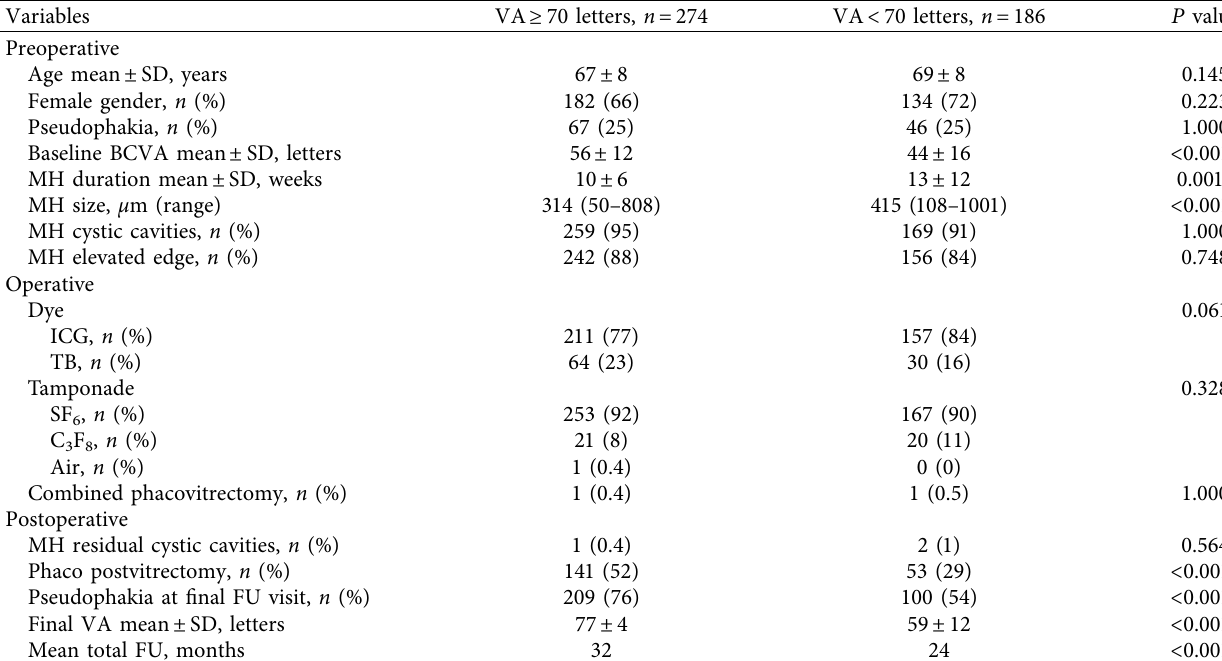
Table 1: Baseline, intraoperative, and postoperative characteristics in the eyes with final VA ≥ 70 ETDRS letters versus < 70 ETDRS letters following primary vitrectomy for idiopathic full-thickness macular hole.